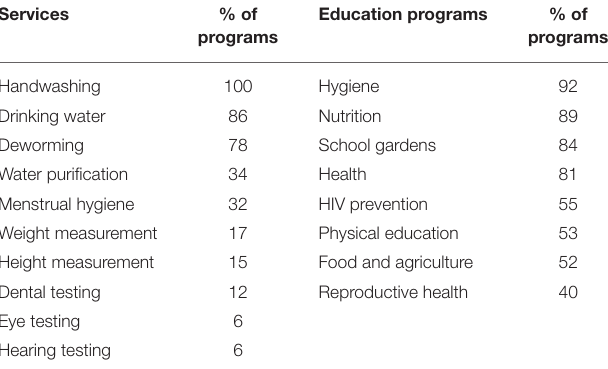
TABLE 3 | Complementary services and education programs.